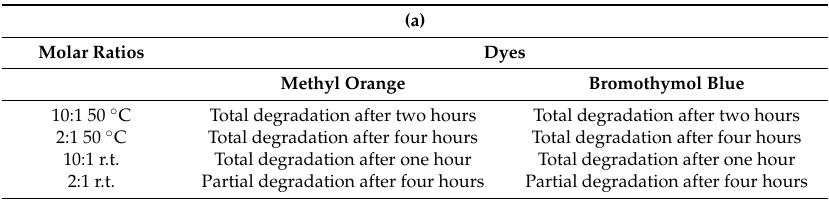
Table 9. ( a ) Qualitative evaluation of the dye degradation for C 12 H 28 O 4 Ti:CO(NH 2 ) 2 ; ( b ) Qualitative